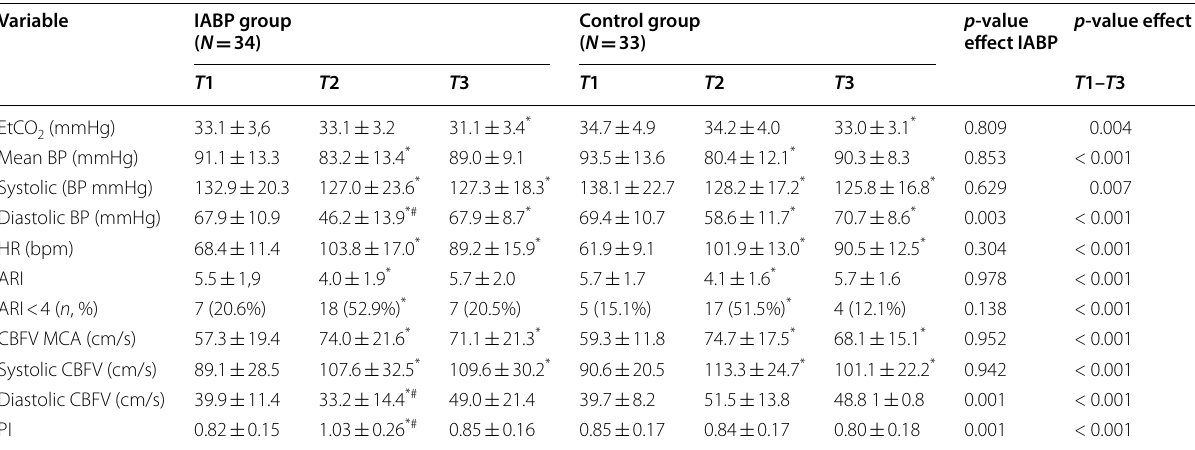
Table 3 Systemic and cerebral hemodynamic